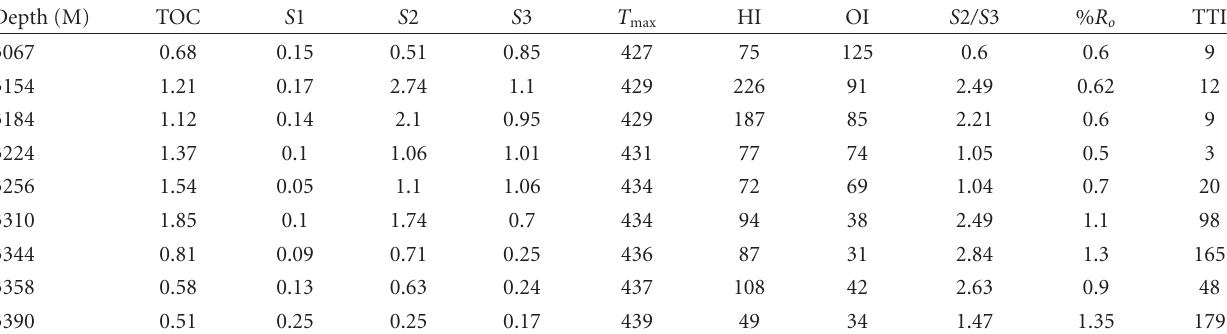
Figure 2: Generalized lithostratigraphic column of Abu Madi gas field modified after [3]. Table 1: Summary of pyrolysis data of Abu Madi-9